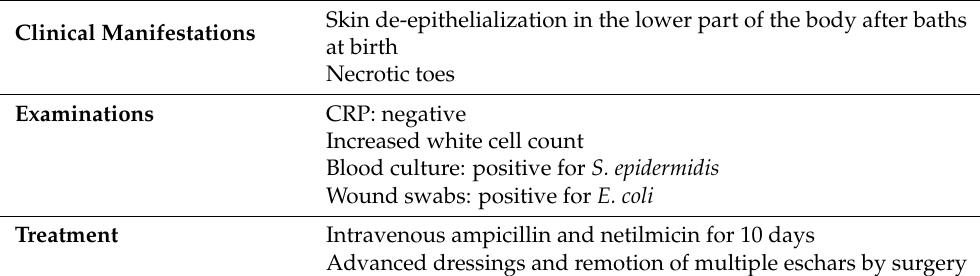
Table 6. Summary of case 4 with severe burns and sepsis due to Staphylococcus epidermidis and Escherichia coli